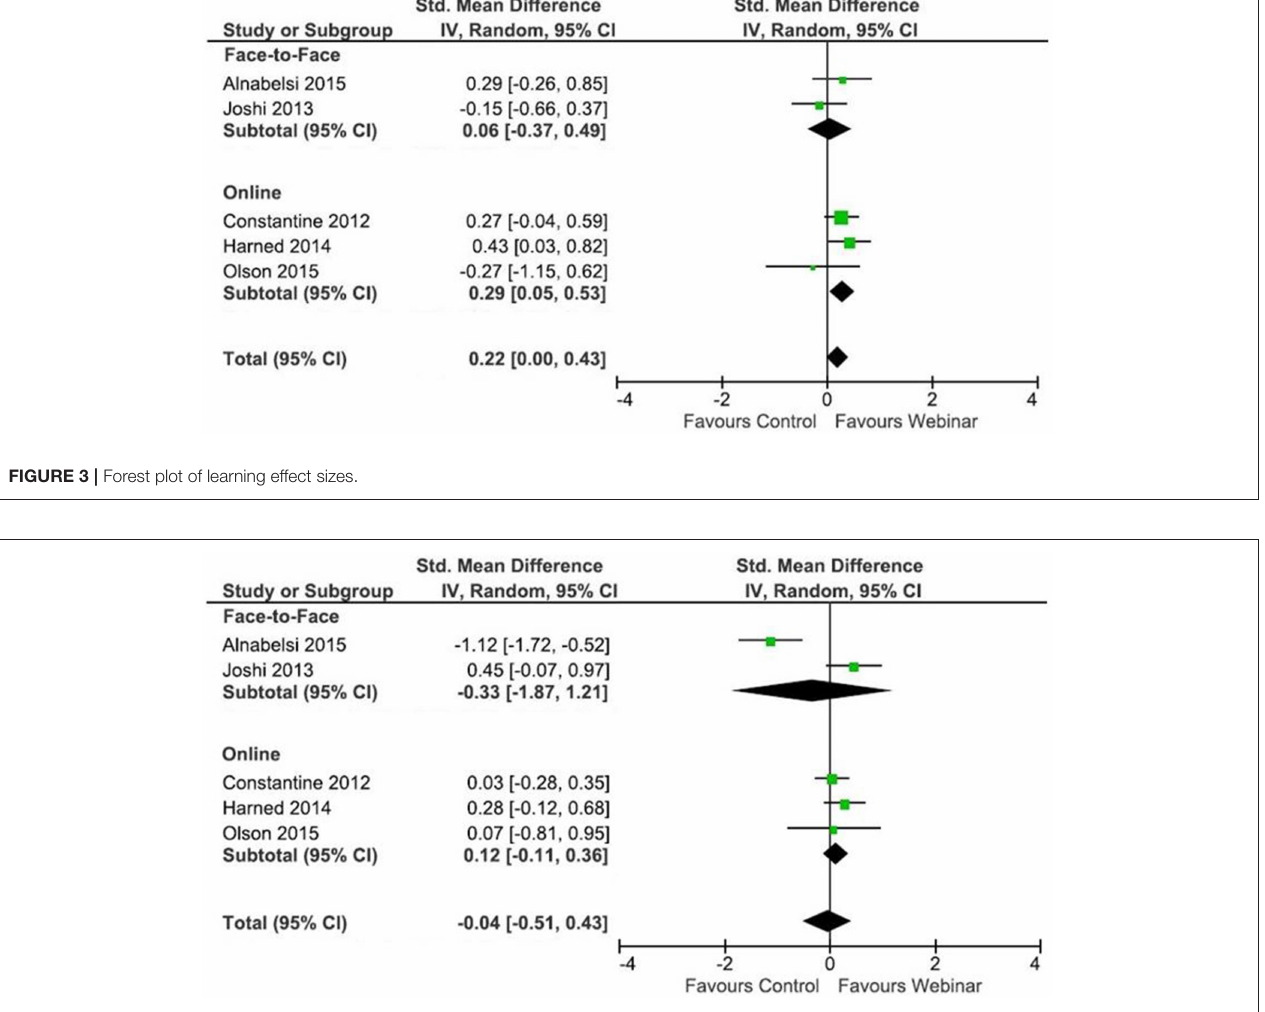
FIGURE 4 | Forest plot of satisfaction effect